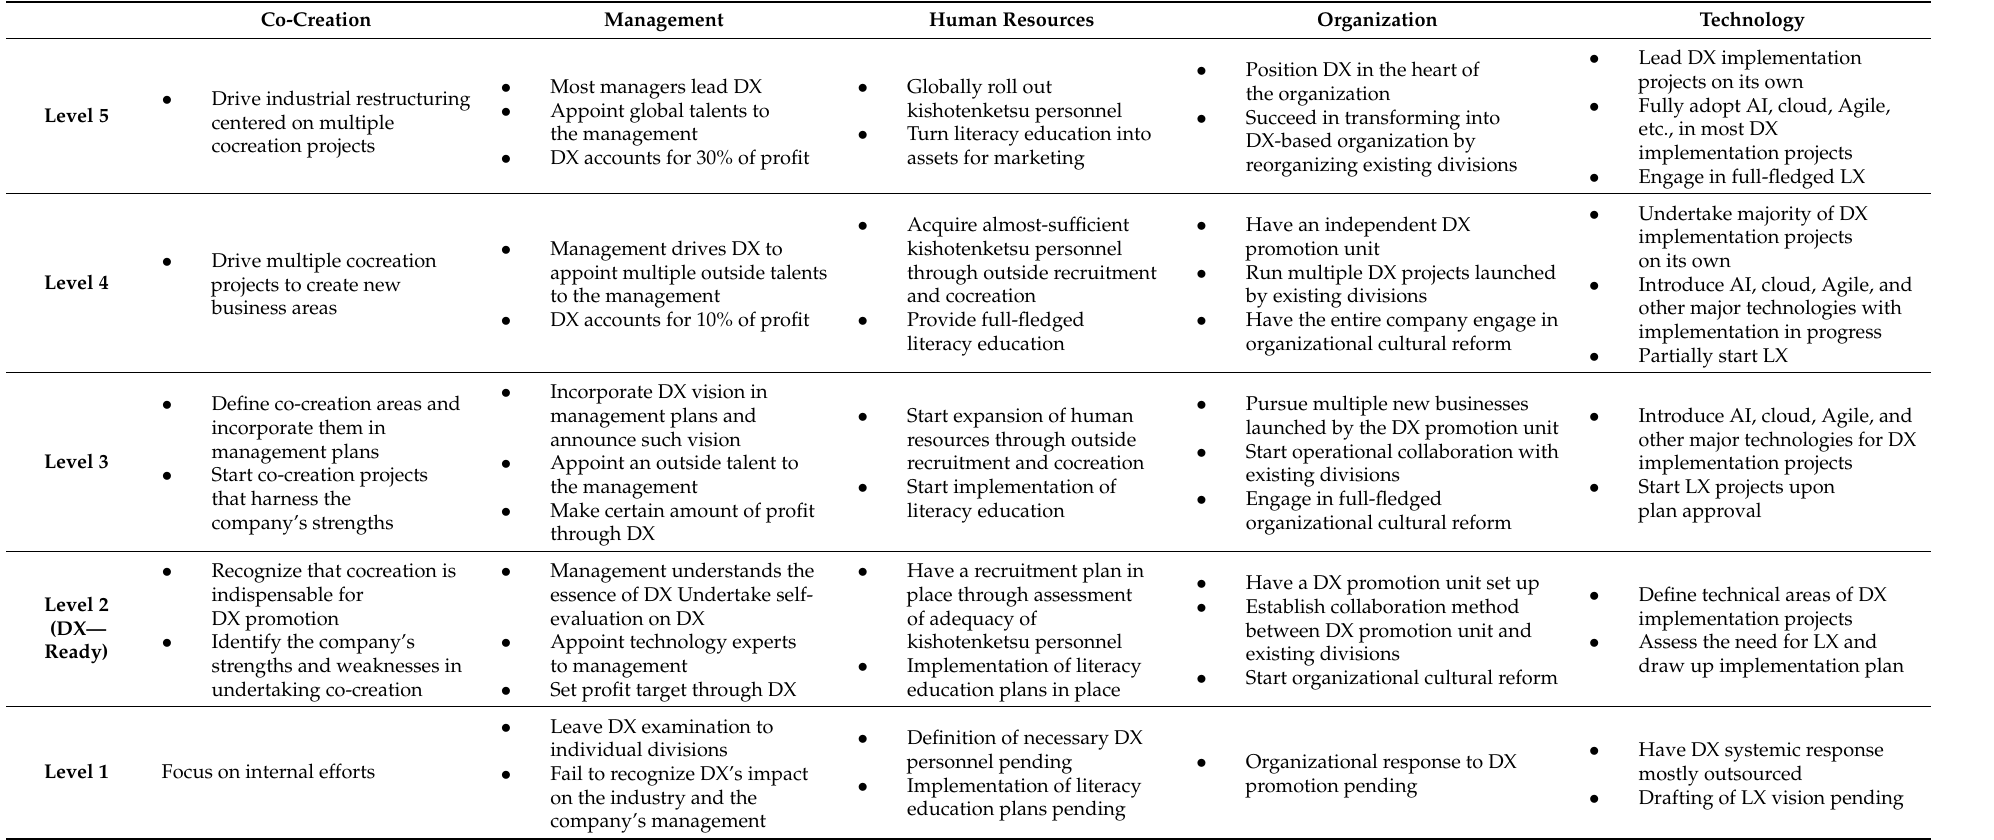
Table 4. Co-Creation DX